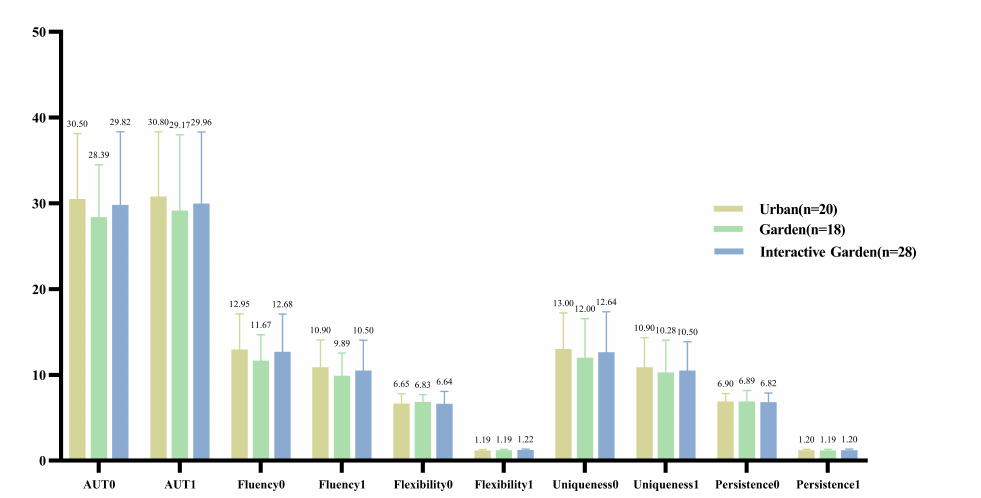
Figure 3. Descriptive statistical results of the scores of AUT.